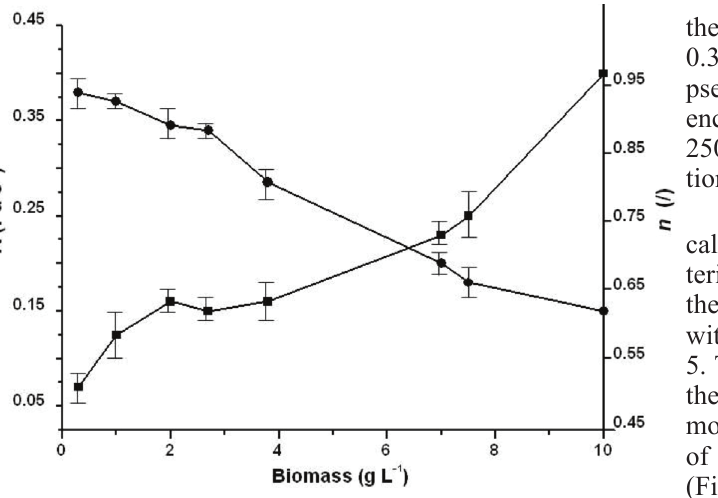
Fig. 5 – Changes in flow behaviour index n (  ) and fluid